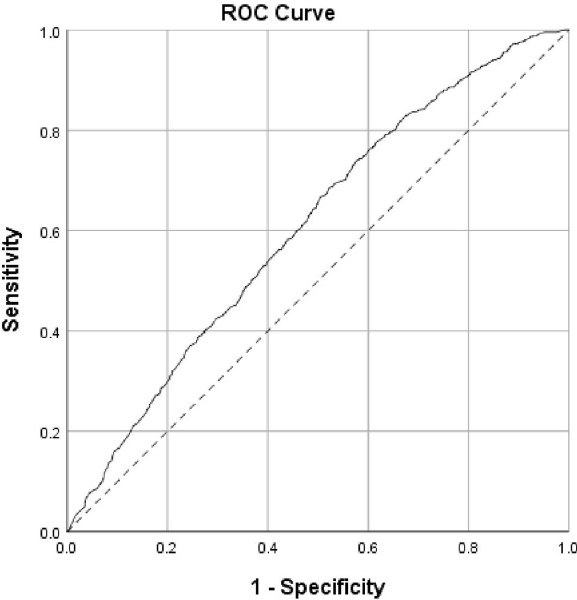
Figure 1. Receiver operating characteristic (ROC) curve for prediction of dyslipidemia by the logistic regression